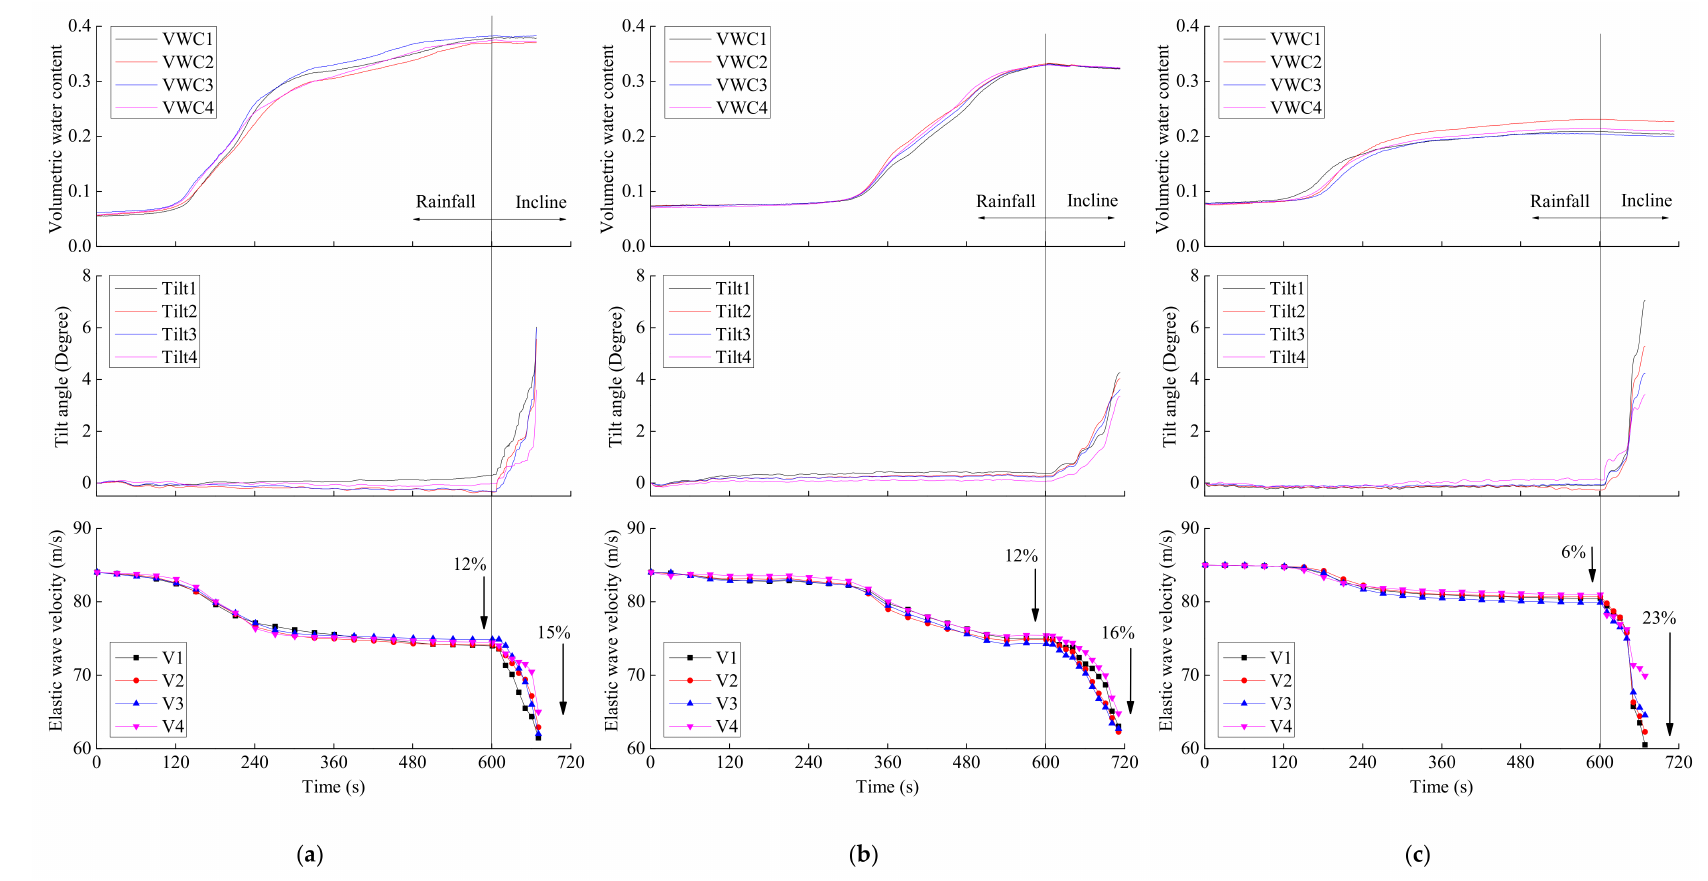
Figure 11. Time series data of volumetric water content, tilt angle and elastic wave velocity by varied model tests with surface layer thickness of ( a ) 5 cm, ( b ) 10 cm and ( c ) 15